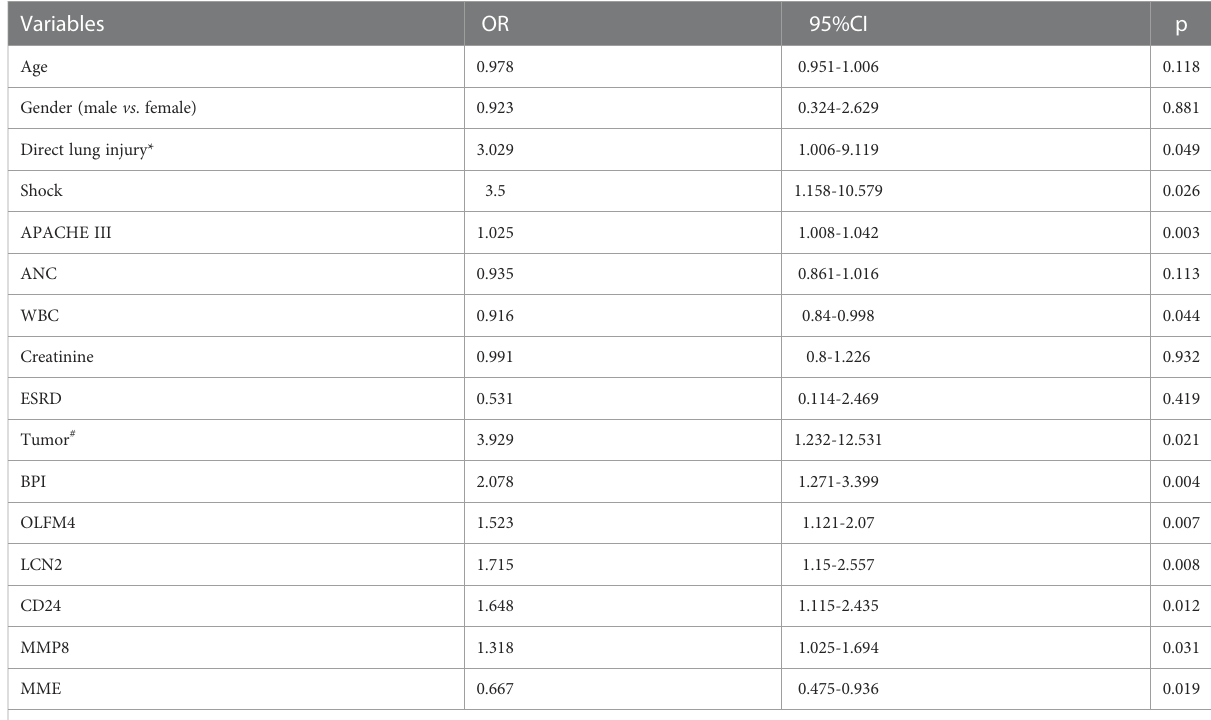
TABLE 2 Univariate analysis of the predictors for the development of ARDS.